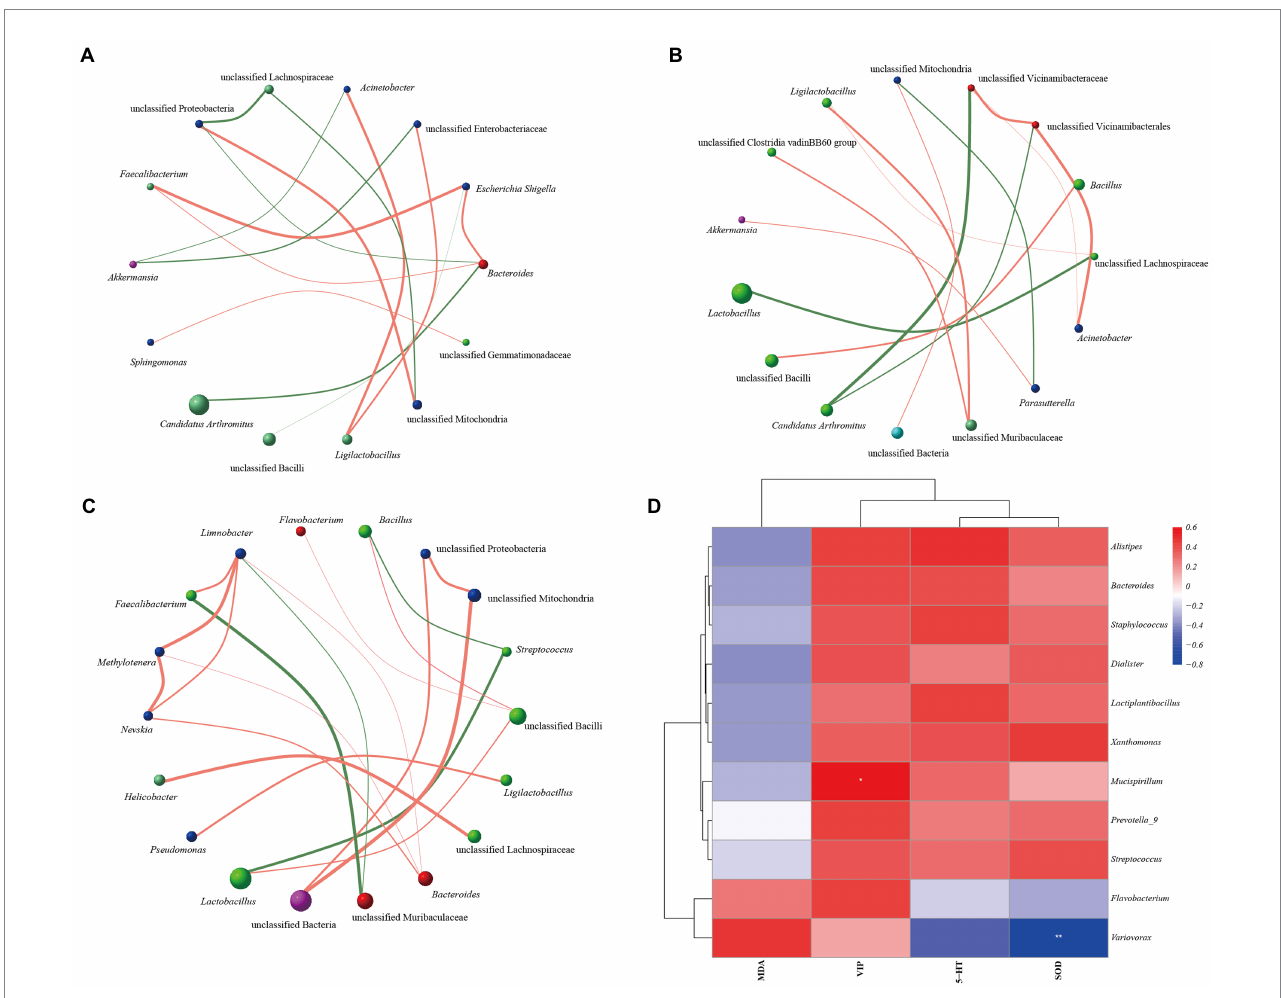
FIGURE 9 Correlation network analysis of intestinal mucosal microbiota in mice with spleen deficiency constipation intervened by SMD. (A) Interaction network between the microbiota of MN group. (B) Interaction network between the microbiota of MR group. (C) Interaction network between the microbiota of MT group. (D) Heat map of correlation analysis between microbiota and